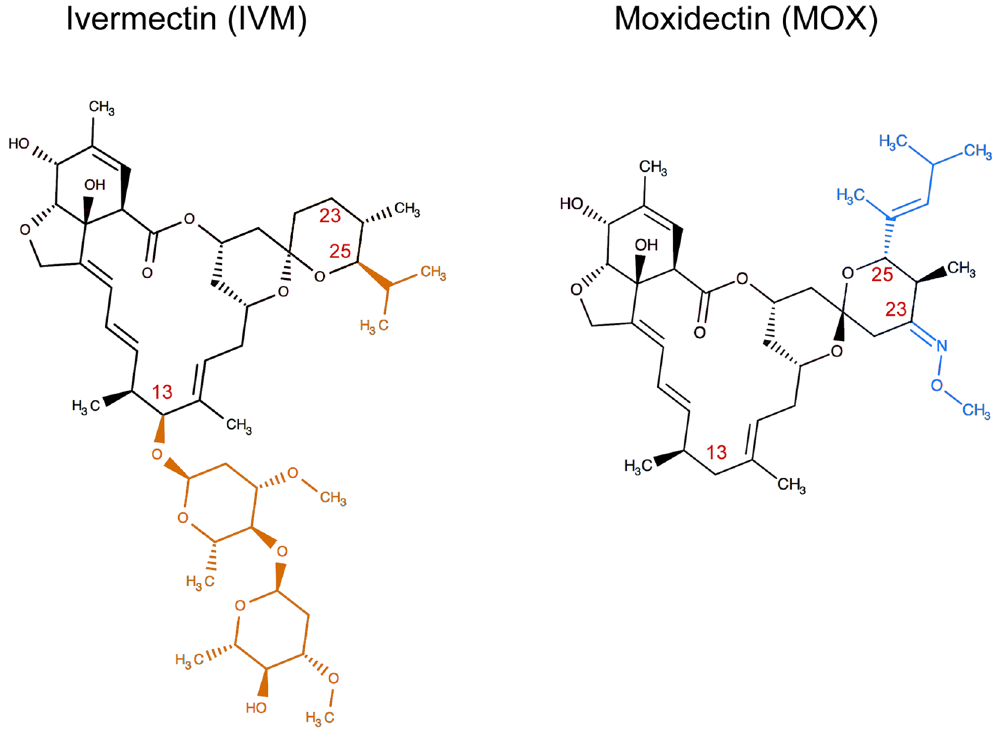
Figure 1. Comparison of the chemical structure of ivermectin (IVM) and moxidectin (MOX). The substituents that differ from IVM and MOX are highlighted in orange and blue, respectively. Red numbers indicate the